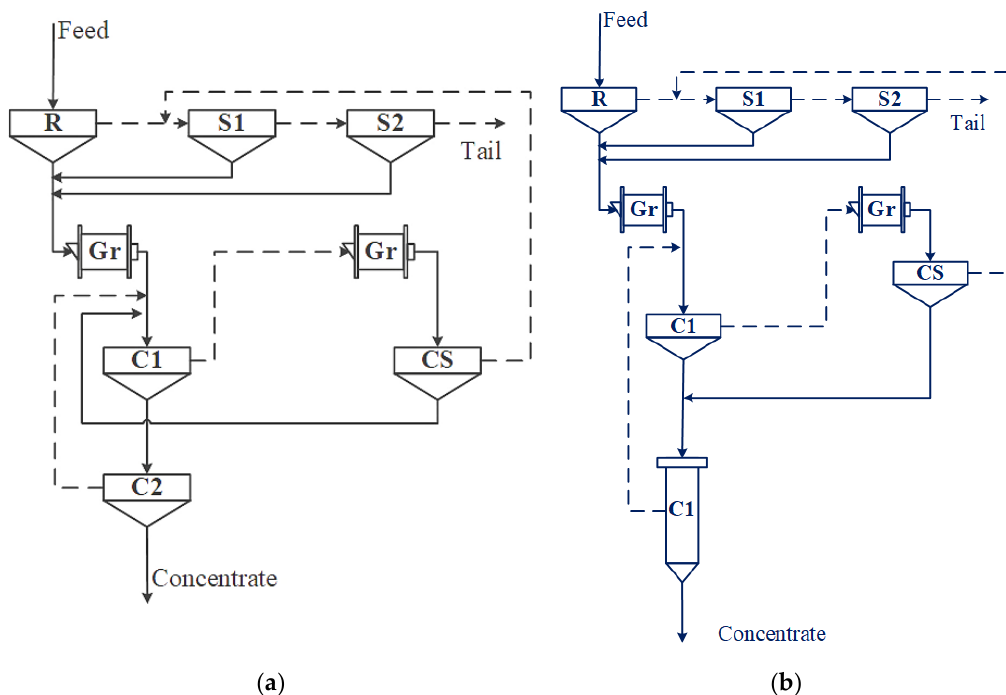
Figure 3. Predominant structures in each instance: ( a ) structure 1; ( b ) structure 2.